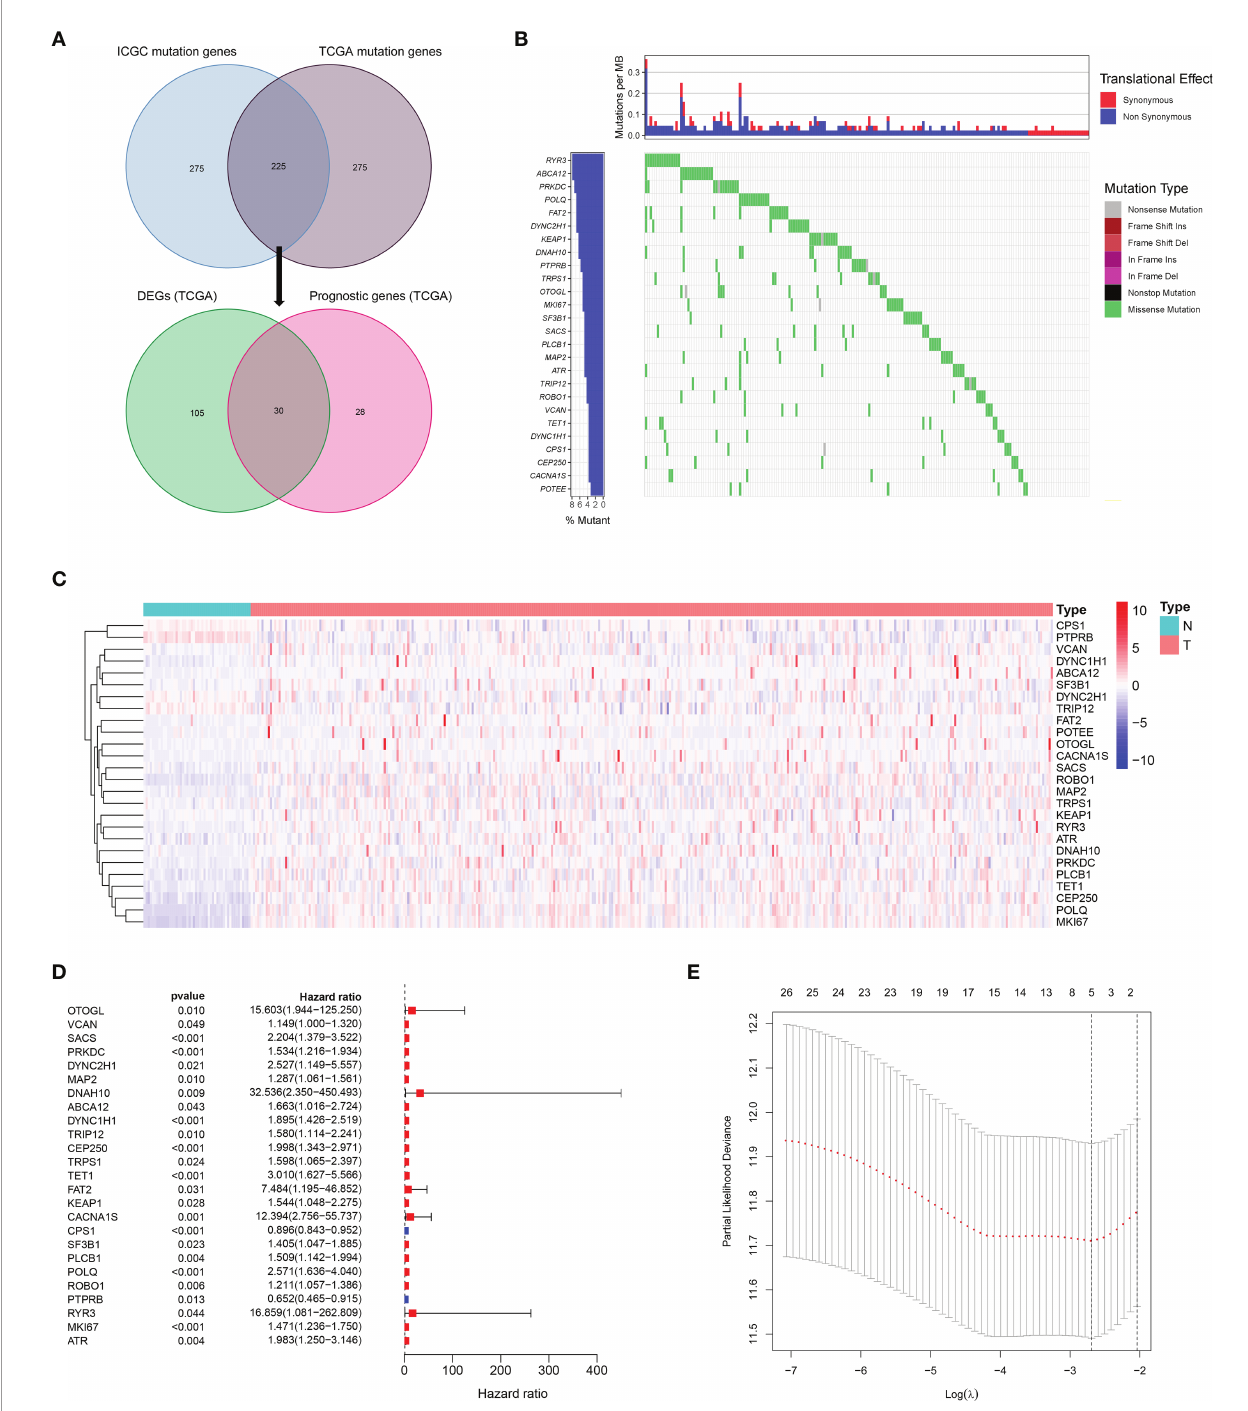
FIGURE 2 | Landscapes of frequently mutated genes in HCC. (A) Venn diagram of mutated genes. The 225 mutated genes were from both TCGA and ICGC datasets. The 30 mutated genes with prognostic value were from TCGA dataset. (B) Waterfall plot displays the 26 mutated genes in HCC from TCGA dataset. The left panel presents the genes ordered by mutation frequencies. The right panel shows different types of mutation. (C) The heatmap of the 26 DEGs between 365 HCC tissues and 50 nontumor tissues. (D) Forest plot shows the 26 DEGs for OS. (E) LASSO coef fi cient spectrum of candidate genes in